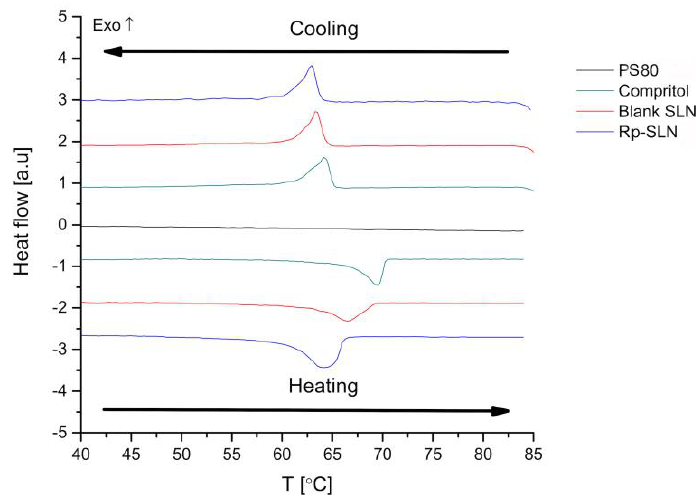
Figure 4. Heating and cooling ramps of blank and Rp-SLN compared to bulk compritol and PS80.